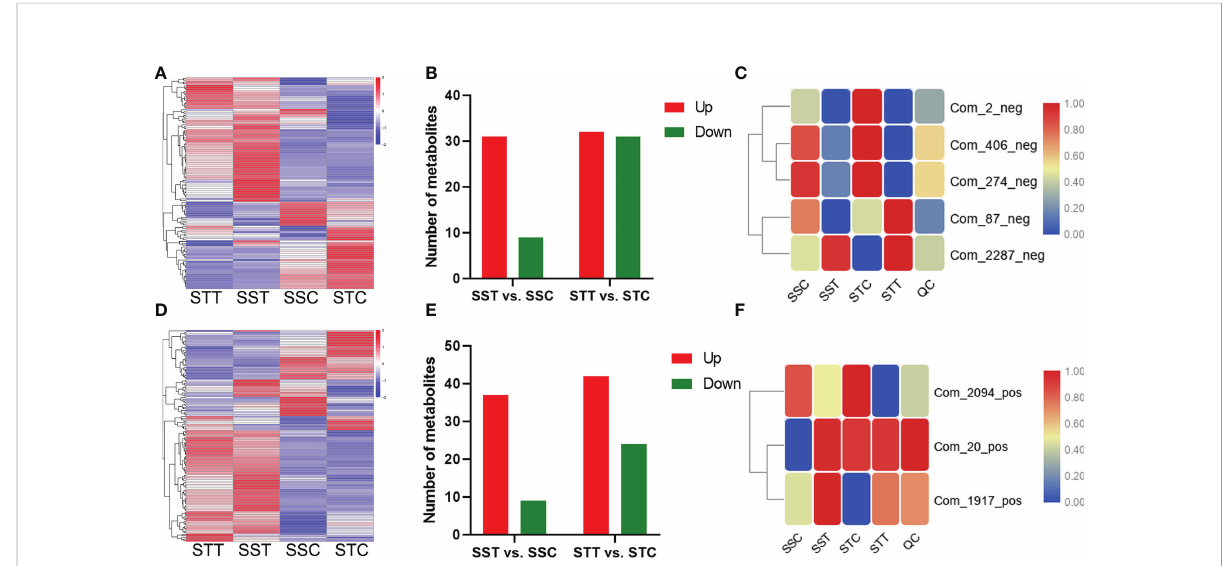
FIGURE 5 Differential metabolites respond to salt stress. (A, D) mean the differential metabolite content in different groups under negative and positive modes, respectively. The redder the circle, the higher the content. (B, E) showed the differential metabolite content in different comparisons under negative and positive modes, respectively. (C, F) showed the candidate metabolite pro fi le content in different groups under negative and positive modes, respectively. The redder the circle, the higher the